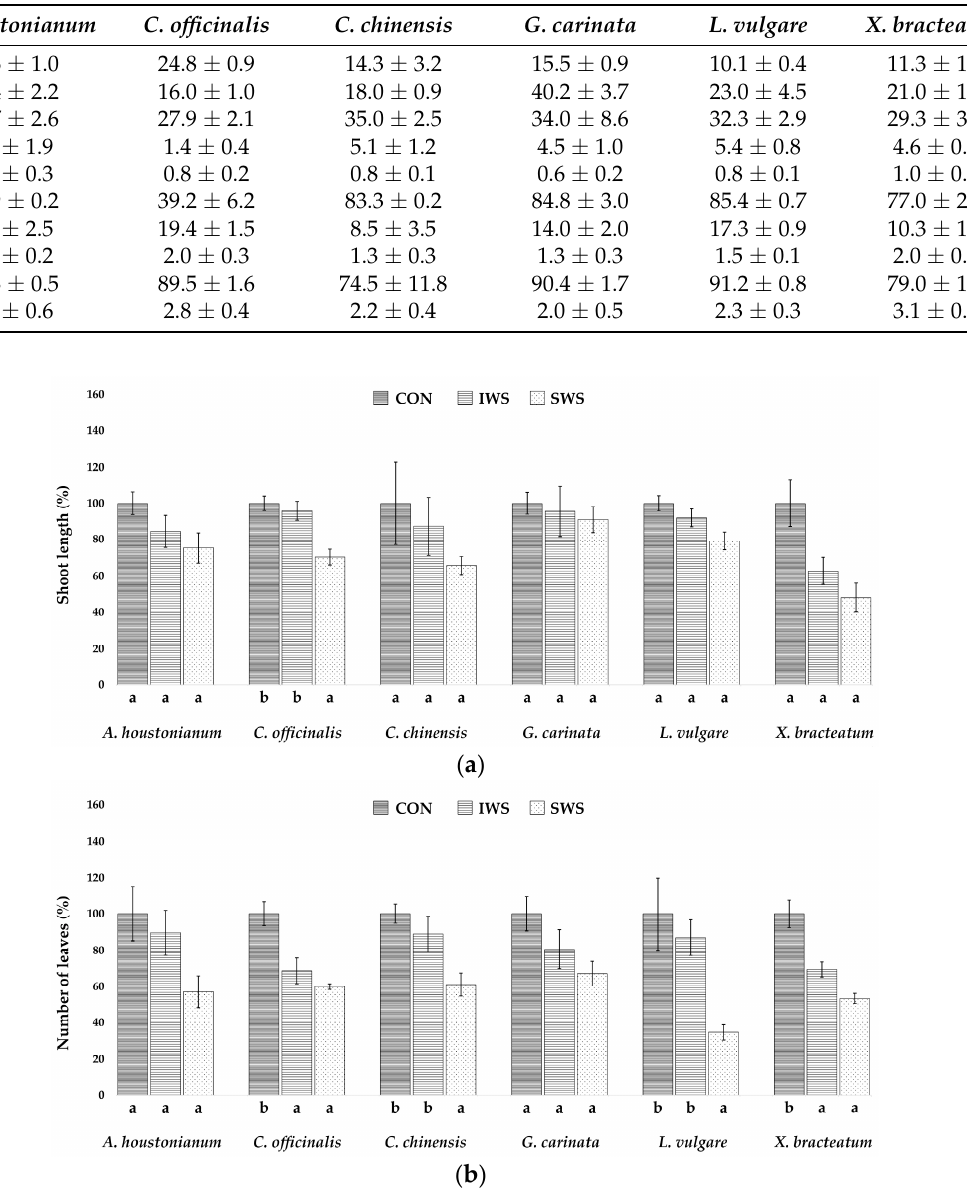
Figure 2. Effect of water stress on the shoot length ( a ) and number of leaves ( b ) in the six investigated Asteraceae species. Bars indicate mean values with SE ( n = 5) of percentage relative to the control averages for each species, shown in Table 1. Different lowercase letters indicate significant differences between treatments (CON—control, IWS—intermediate water stress, and SWS—severe water stress) per species, according to the Tukey test ( p <